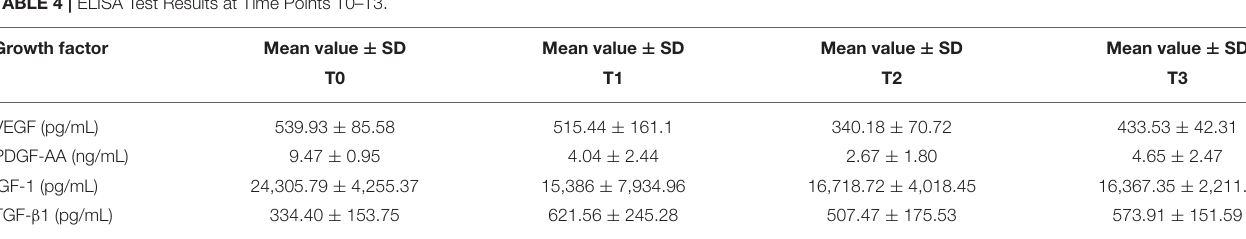
TABLE 4 | ELISA Test Results at Time Points T0–T3. Growth